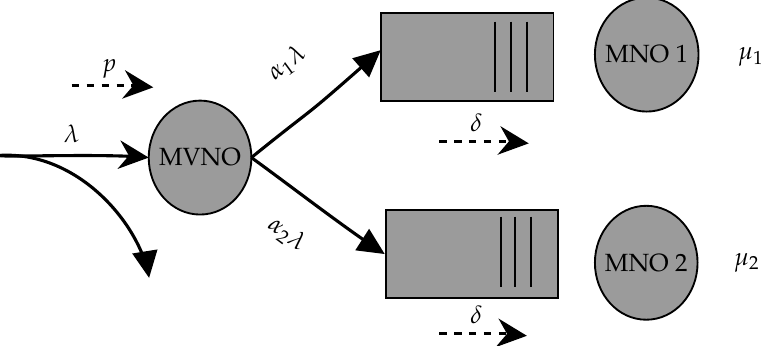
Figure 1. System Model: Users mean arrival rate ( λ ), Mobile Virtual Network Operator (MVNO) split factor ( α i ), Mobile Network Operator (MNO) i packets mean arrival ( λ i ), MNO i network capacity ( µ i ), price charged MVNO ( p ), fee paid by the MVNO ( δ ), network traffic flow ( −→ ), price and fees flow ( (cid:57)(cid:57)(cid:75) ).